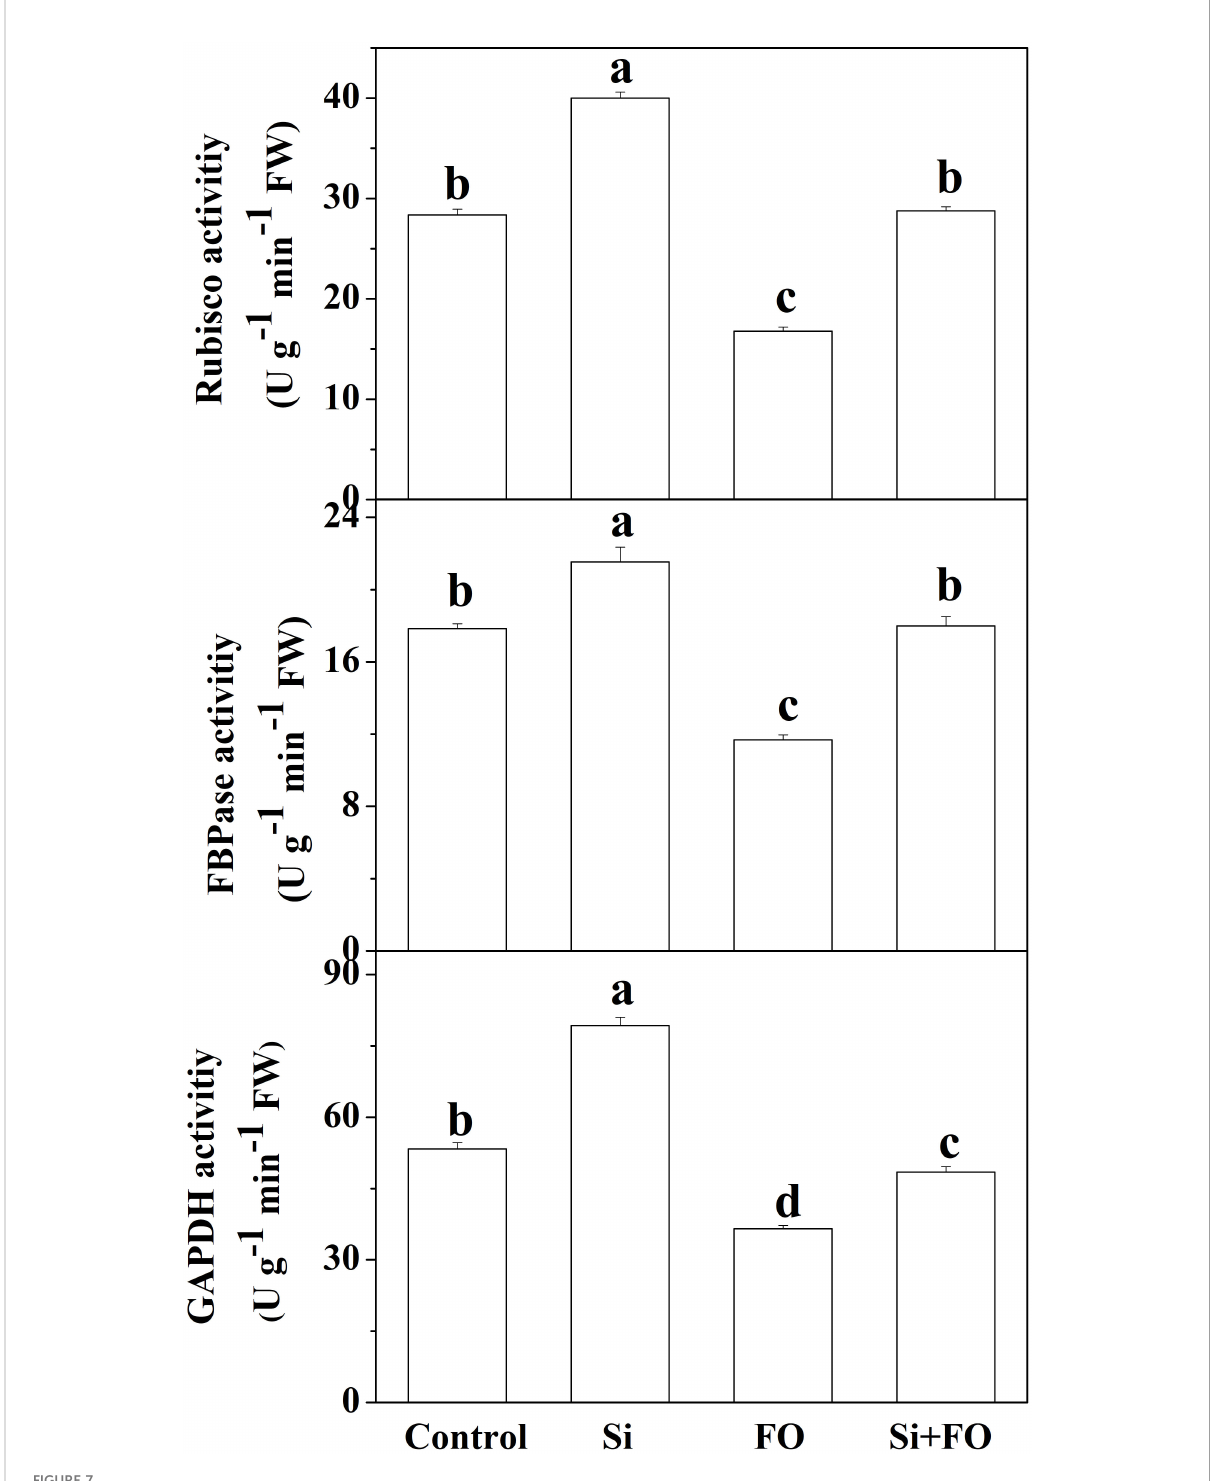
FIGURE 7 Effects of exogenous silicon application on activities of Rubisco, FBPase, and GAPDH in cucumber leaves. Means denoted by the different lowercase letters are signi fi cantly different according to Tukey ’ s test ( P ≤ 0.05); the mean represents the average of three replicates ± standard deviation (SD). Control: plants were irrigated with sterilized water; Si: plants were irrigated with exogenous silicon (3 mmol·l -1 Si); FO: plants were only inoculated with Fusarium ; Si+FO: plants were irrigated with exogenous silicon followed by inoculation with